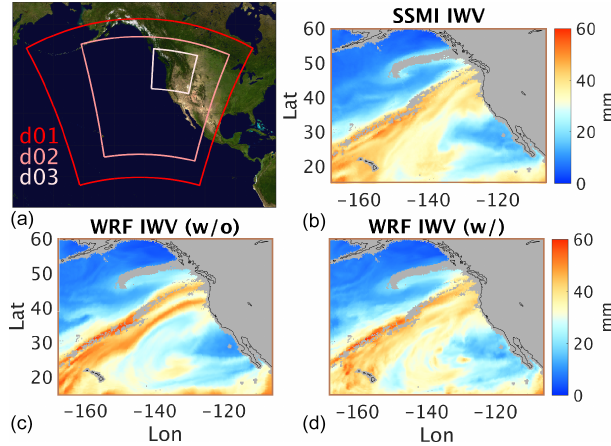
Figure 11. (a) WRF model domain configuration for the Novem- ber 2006 AR event. (b) TCWV observed by SSM/I on 6 Novem- ber 2006. (c, d) TCWV simulated by WRF on the same day (c) with- out and (d) with OMI TCWV data assimilation. Gray indicates area with no SSM/I